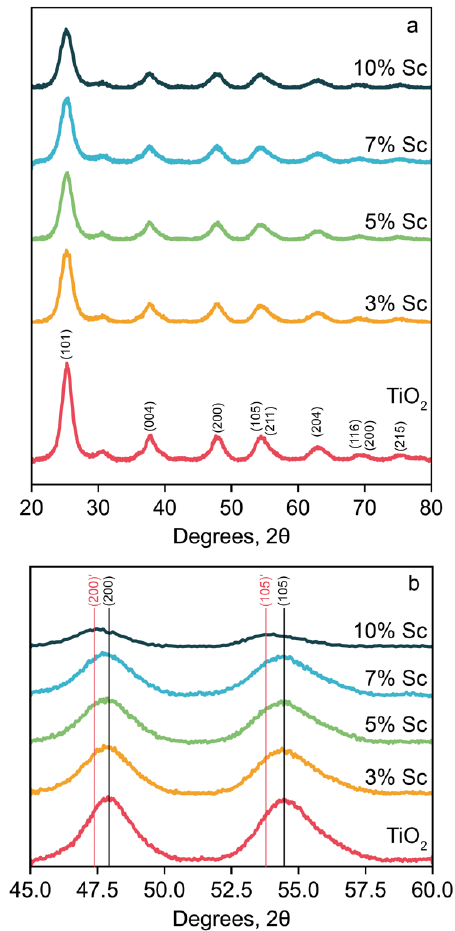
Figure 2. X-ray diffraction (XRD) patterns of pure TiO 2 and Sc-doped samples in fields 2 θ = 20° – 80° ( a ) and 2 θ = 45° – 60° ( b ).